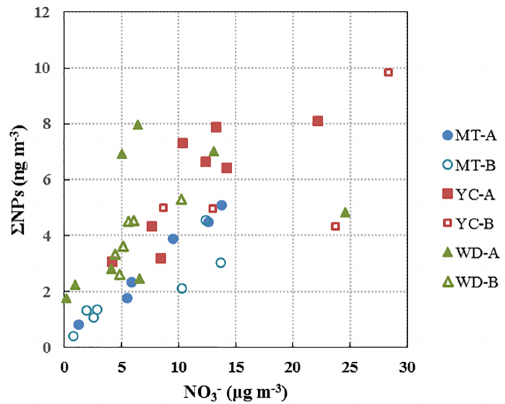
Figure 6. Scatter plot of particulate nitrated phenols with fine in- organic nitrate at the rural and mountain sites. A and B indicate daytime and nighttime samples,